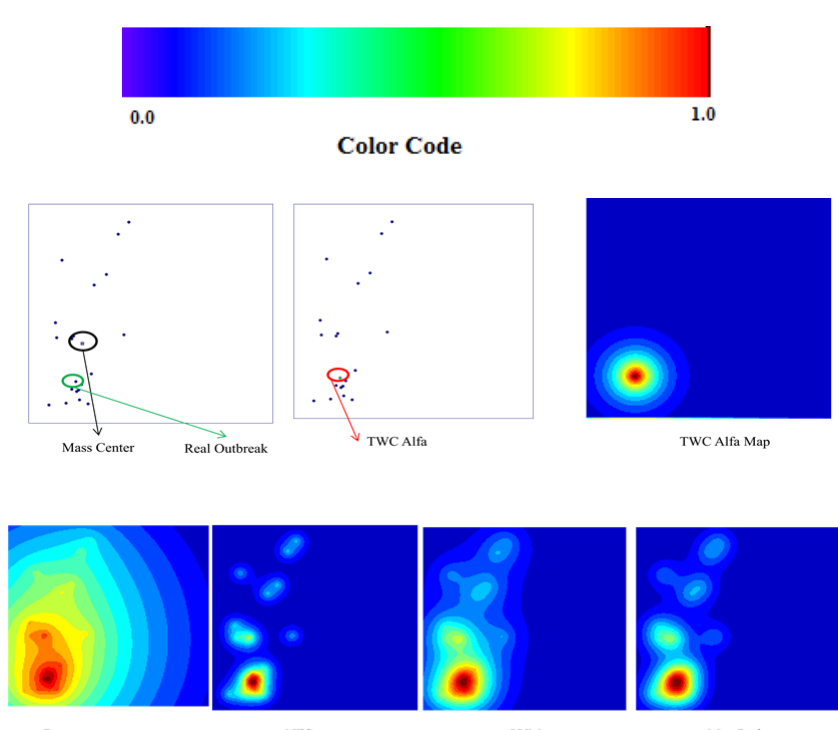
Figure E2. The Foot and mouth disease epidemic of 1967.